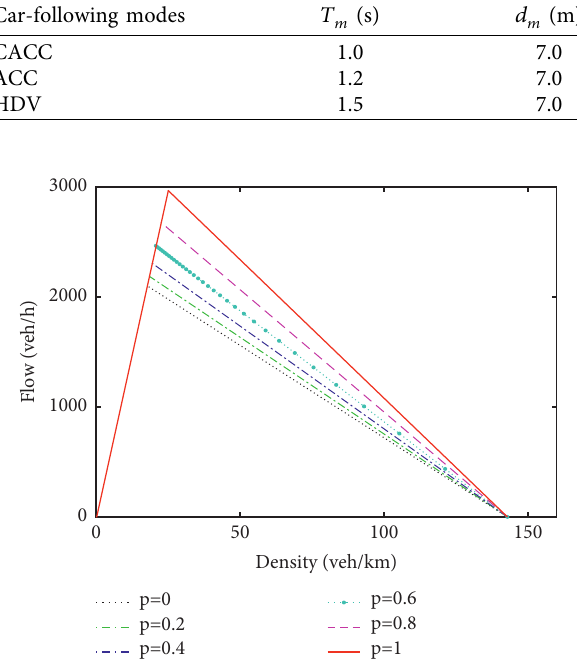
Figure 7: Fundamental diagram of mixed traffic flow under dif- ferent MPR of